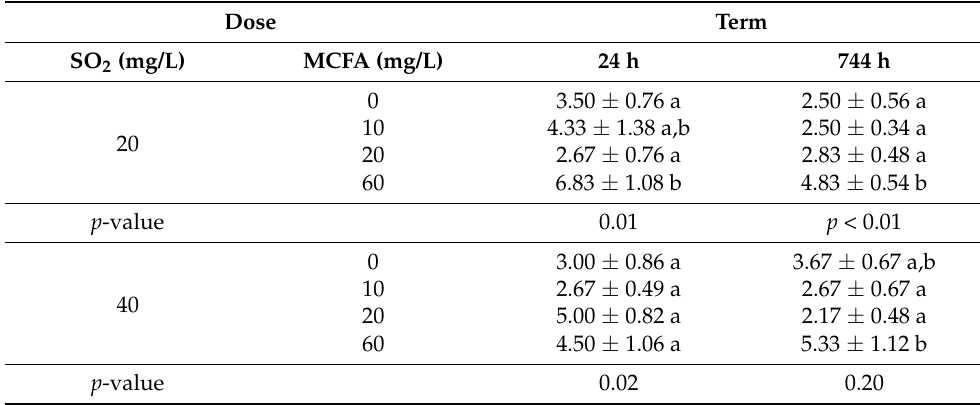
Table 1. Results of sensory analysis. The average values ( n = 3) are supplemented by the contribution into homogeneous groups (a, b) according to Fisher’s LSD (least significant difference) test ( α = 0.05).